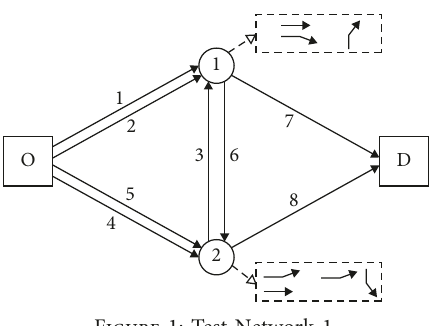
Figure 1: Test Network-1.